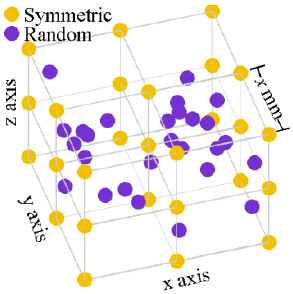
Figure 1. Symmetric and random 27 IMUs configurations.